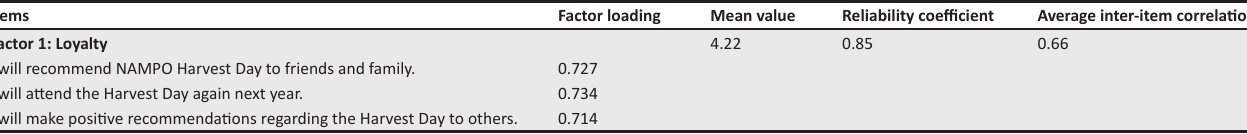
TABLE 2: Factor analysis results of loyalty.